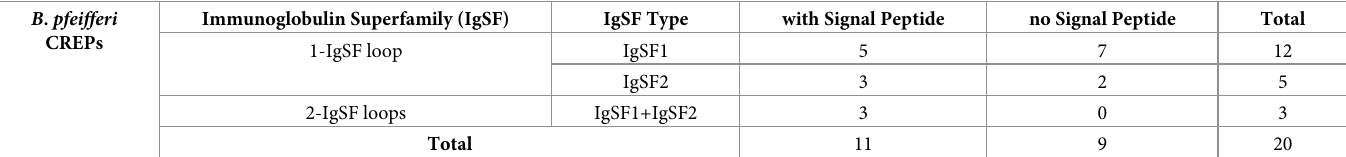
Table 6. Summary of B . pfeifferi